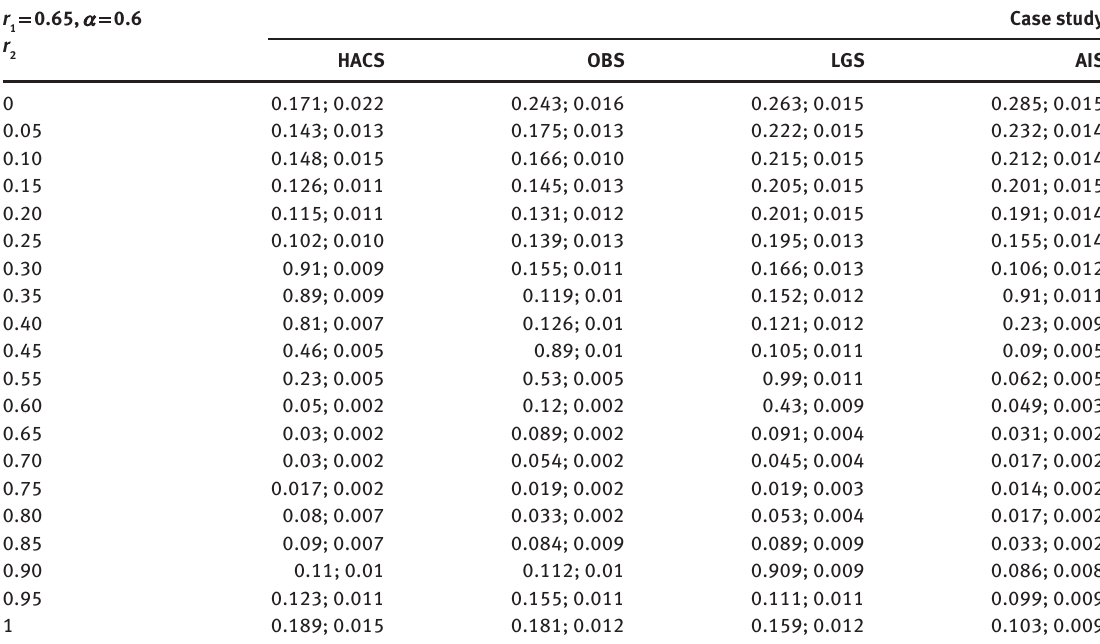
Parameter on the DBI Criterion Using the Four Cases (Average of 30 Runs). Table 3: Effects of r 2 = 0.65, α = 0.6 r 1